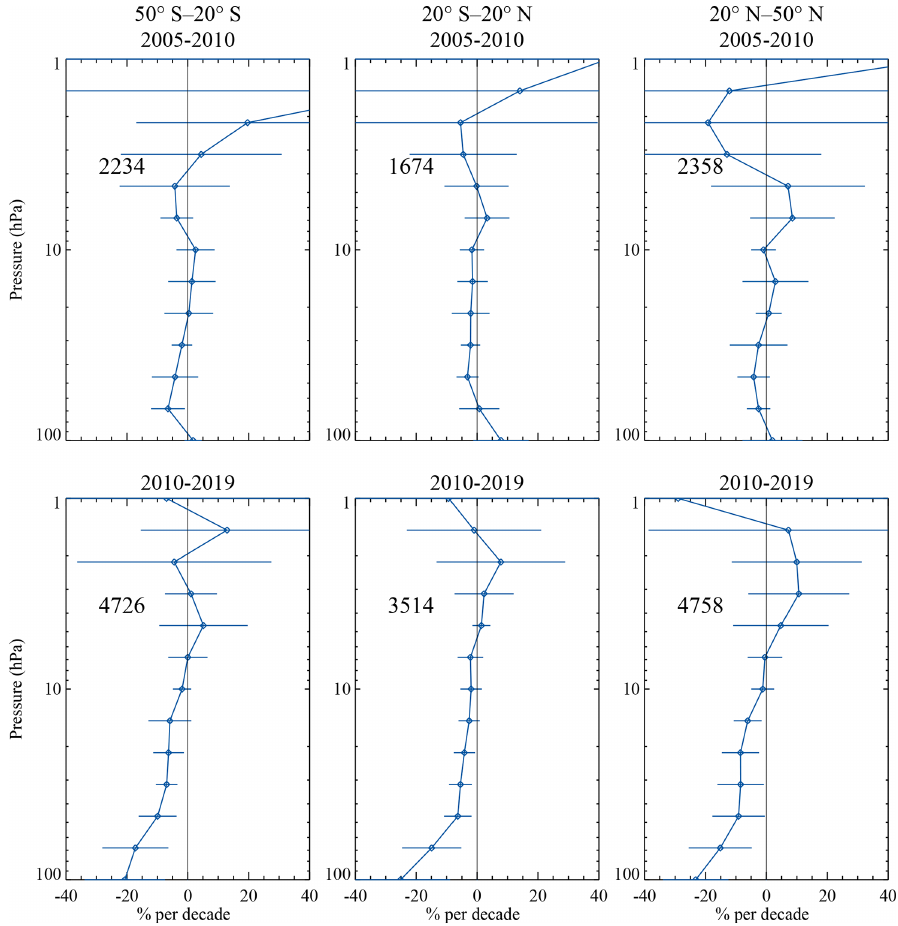
Figure 10. Figure 10 is the same as Fig. 2 but compares the MLS 190GHz N 2 O product with the N 2 O measurements from ACE-FTS.